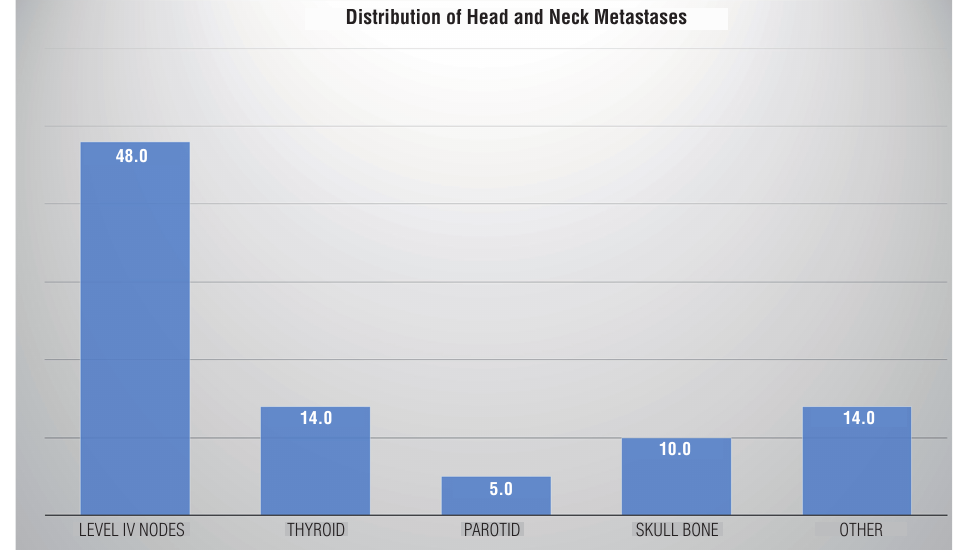
Figure 1 - Distribution of head and neck metastases by location (in % of n=22